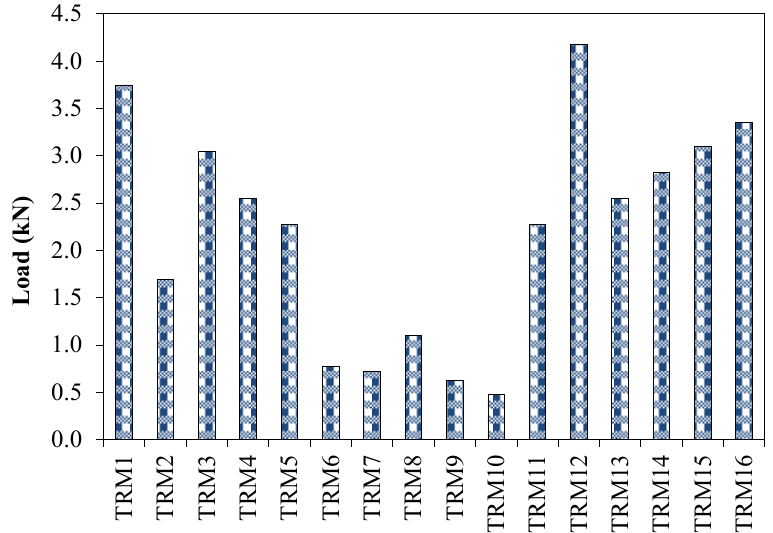
Figure 18. Tensile load carried by TRM strips incorporating various textile fabrics.